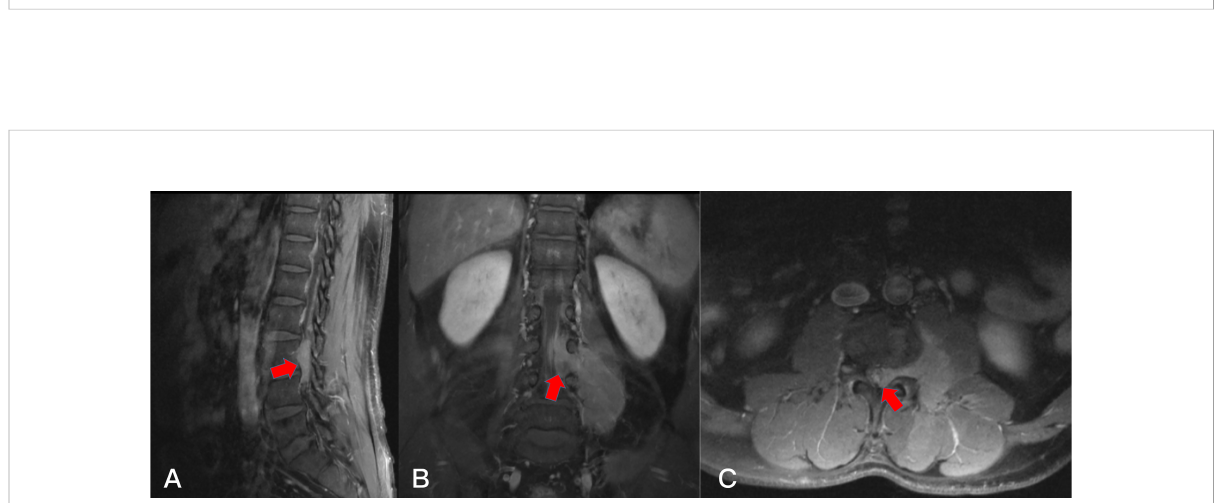
FIGURE 4 Preoperative T1-weighted enhanced MRI on sagittal (A) plane, coronal (B) plane, and axial (C) plane, revealing a dumbbell tumor (Eden II) in the left L3-4 foramen (red arrows).